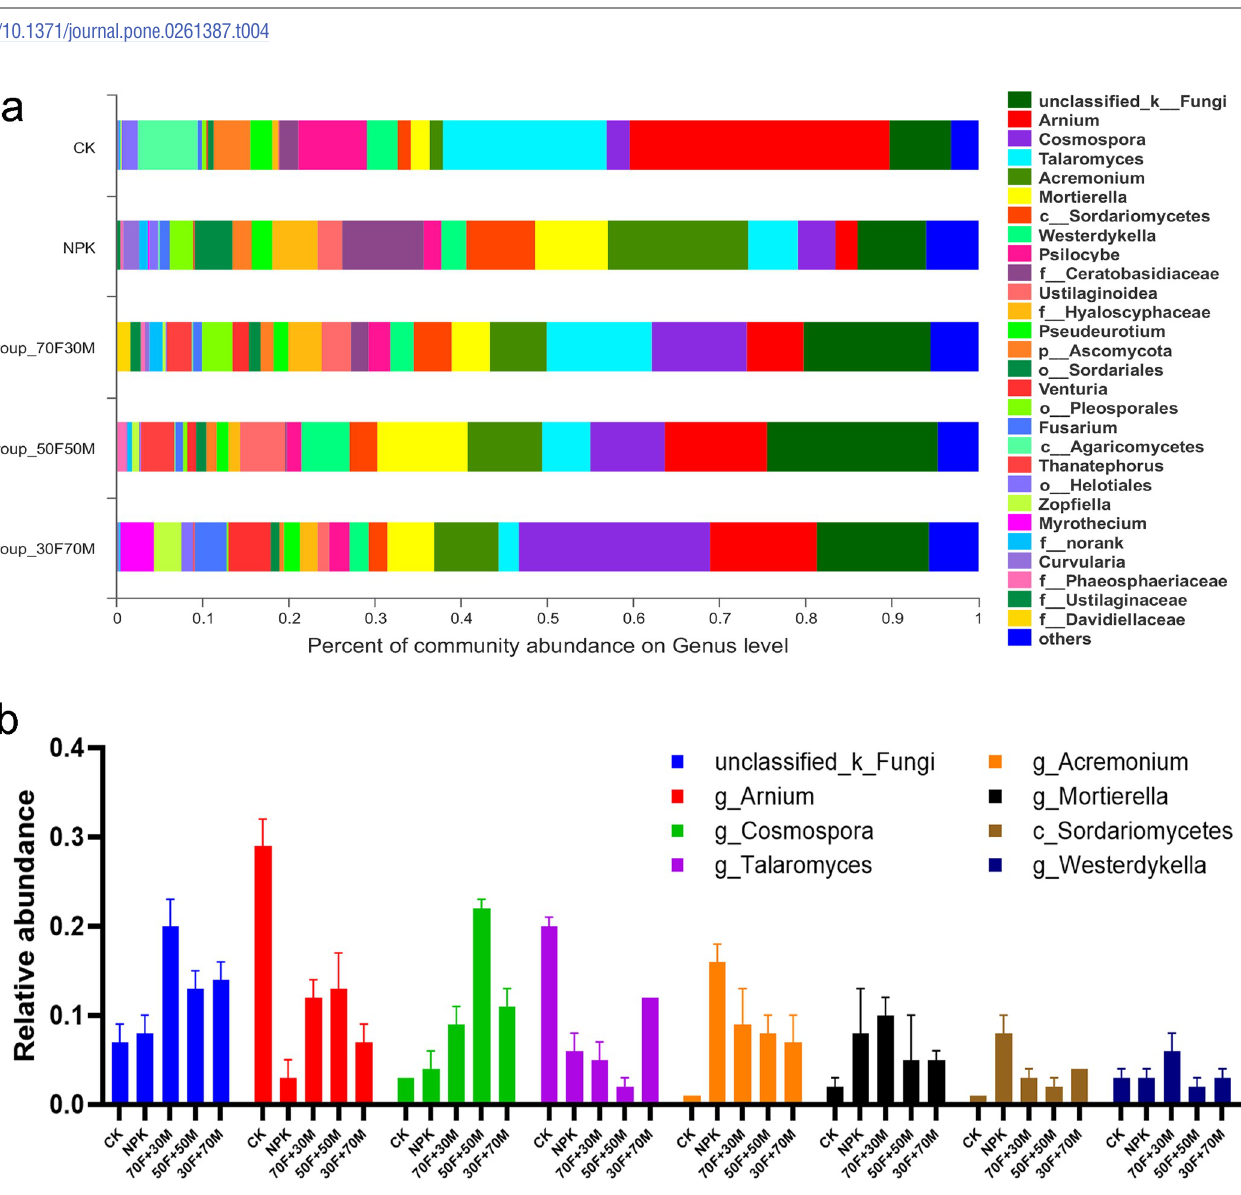
Fig 4. Impacts of various fertilizers on fungal community. (a) Proportion changes in genus level. (b) Relative abundance of fungal genus. Different colors represent different fungi genera. CK: non-fertilization group; NPK: balanced inorganic fertilization; 70F+30M: 70% chemical and 30% organic fertilizer group; 50F+50M: 50% chemical and 50% organic fertilizer group; 30F+70M: 30% chemical and 70% organic fertilizer group.